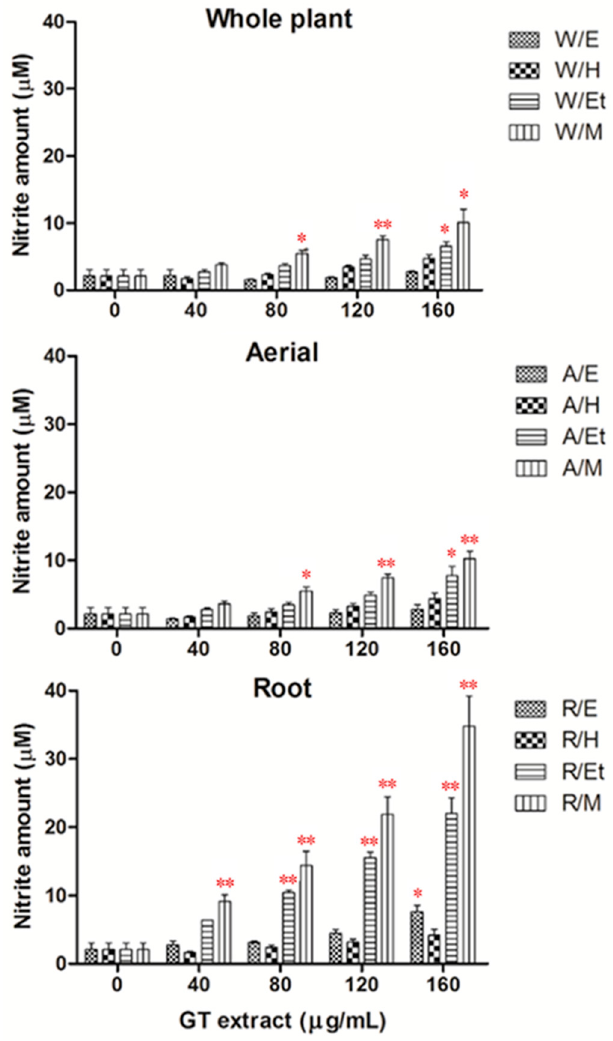
Figure 1. Effects of different extracts from the whole plant, aerial and root of GT on NO production in HUVECs. HUVECs were treated with each extract for 24 h. NO production was determined as the formation of nitrite. Data were obtained from five replicate experiments, and are expressed as mean ± standard deviation. W, whole plant; A, aerial; R, root; E, EA extract; H, hexane extract; Et, ethanol extract; M, methanol extract. A significant difference from the vehicle was indicated as * p < 0.05, ** p < 0.01, (Student’s t -test).